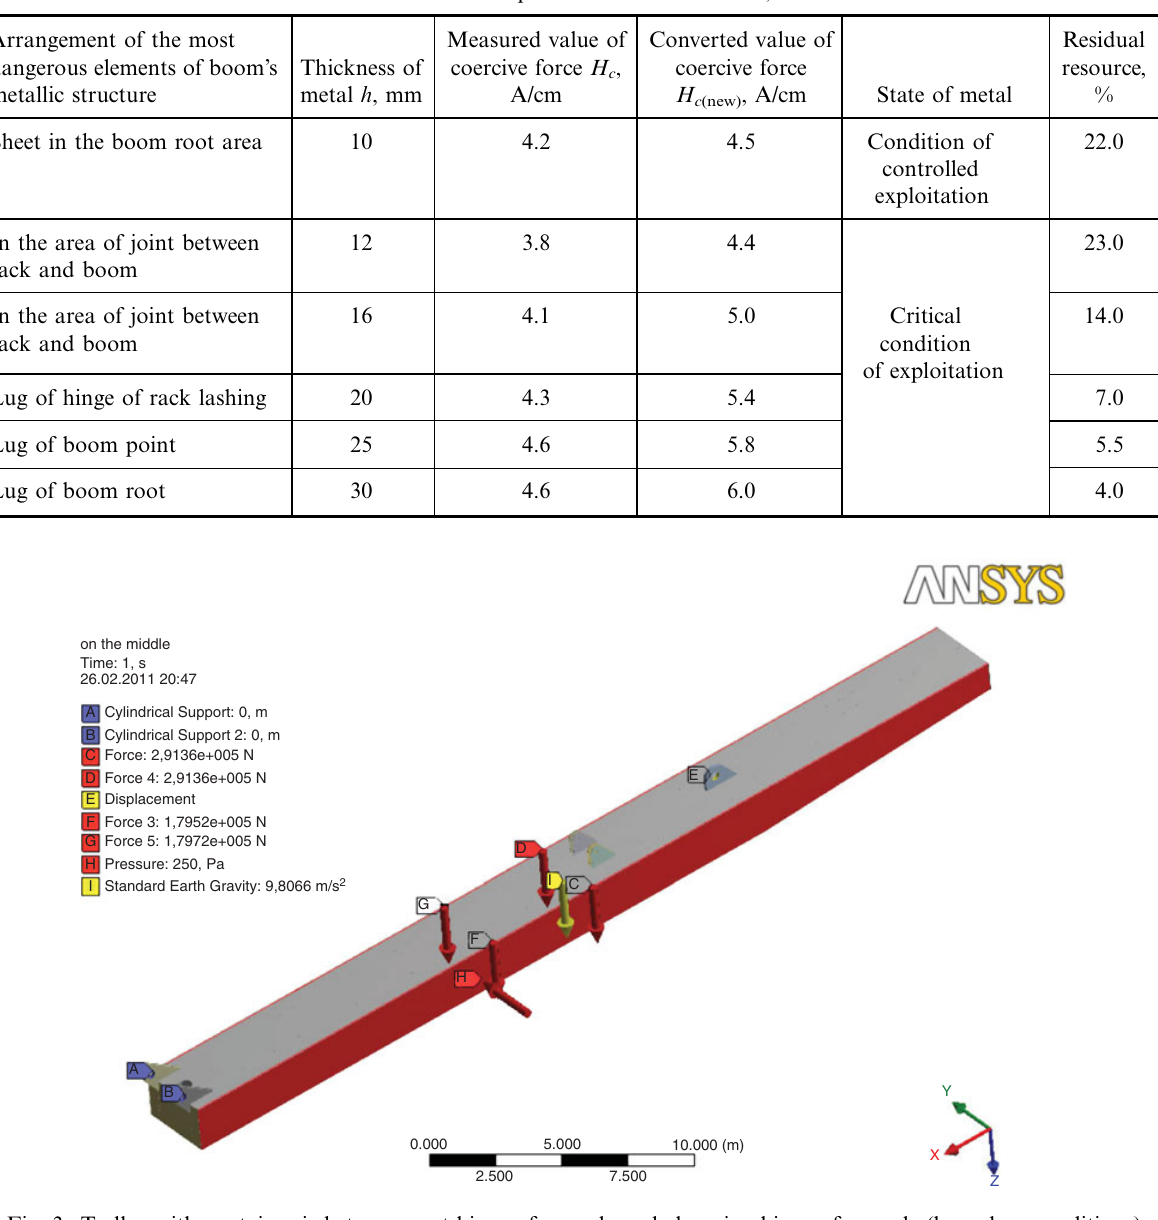
Table 1. Results of control and detection of equivalent of coercive force, assessment of residual resource Arrangement of the most dangerous elements of